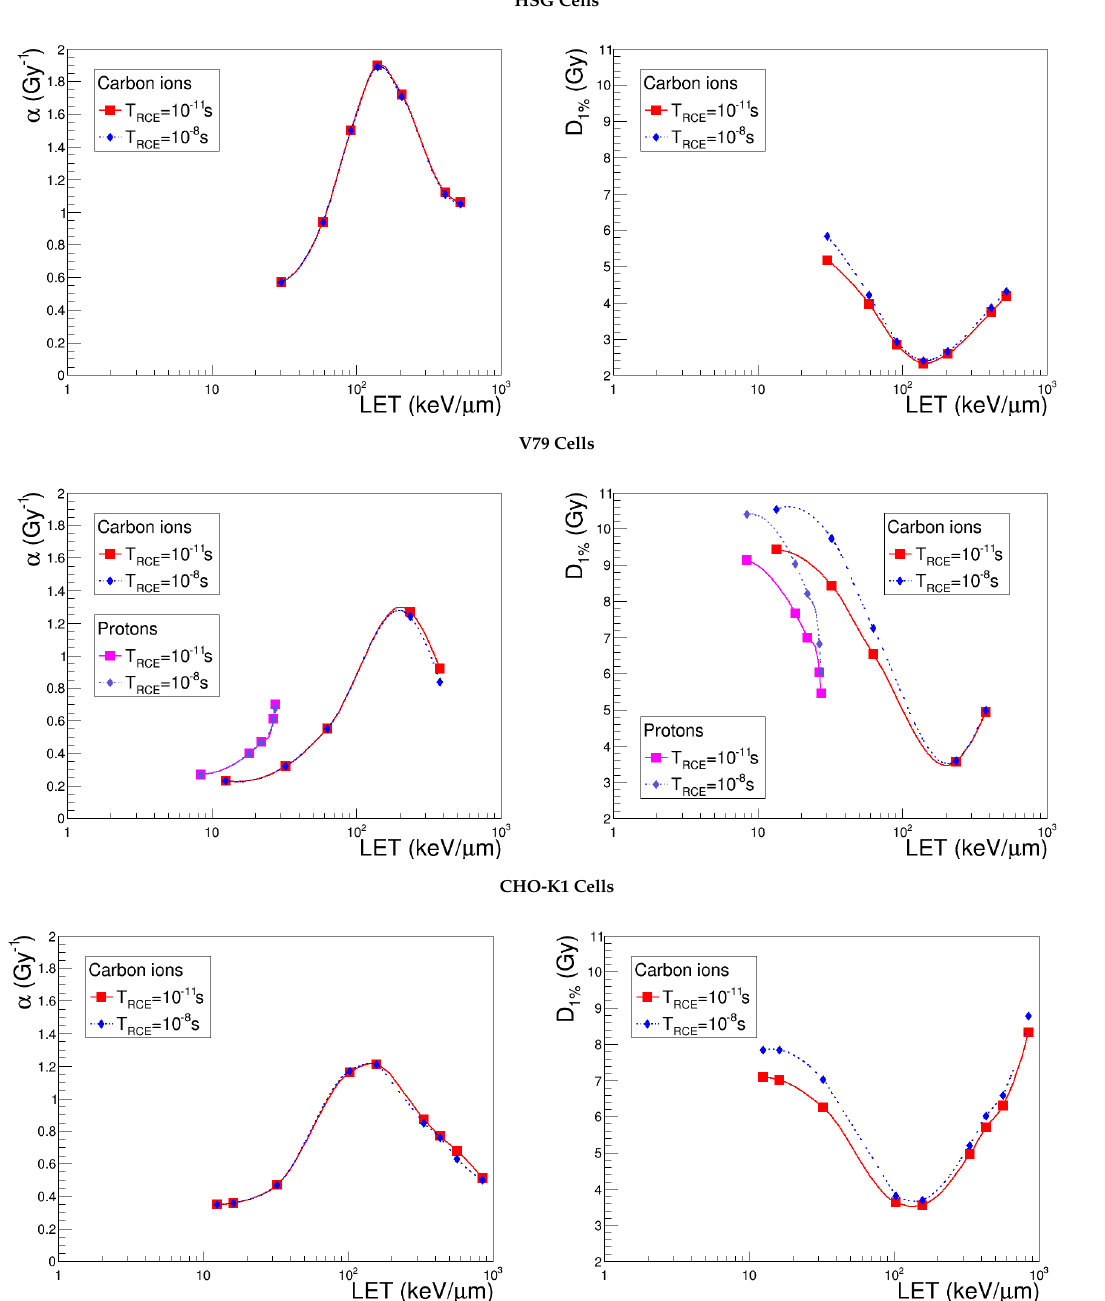
Figure 7. α and D 1% predicted by NanOx for the standard configuration (red curve) and for T RCE = 10 − 8 s (blue curve). The full symbols correspond to the LET values for which the estimates were performed, while the lines are drawn just to guide the eye and do not represent a